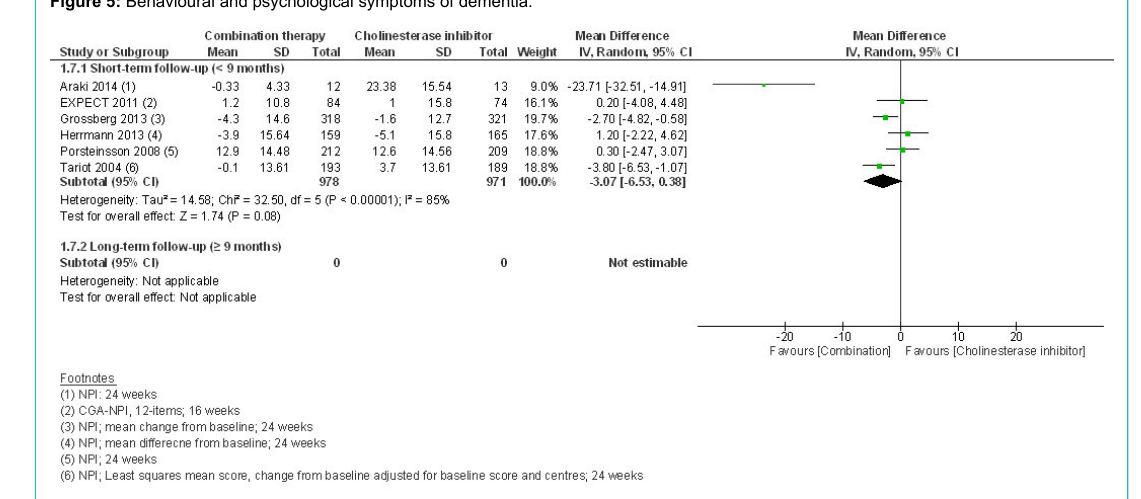
Figure 5: Behavioural and psychological symptoms of